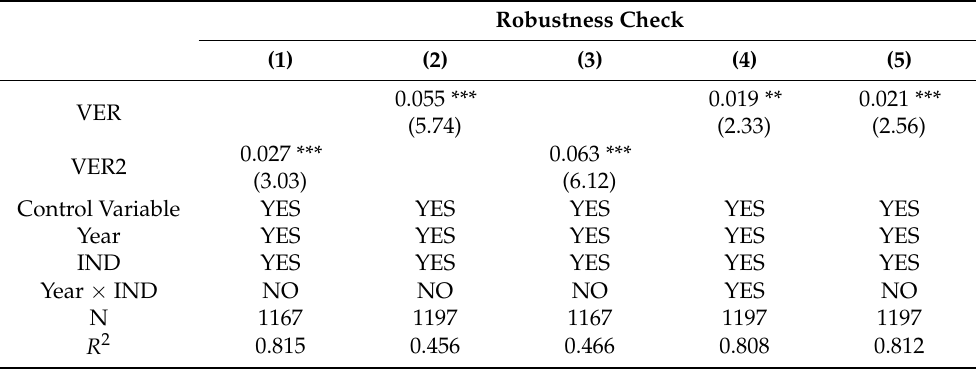
Table 4. Robustness test